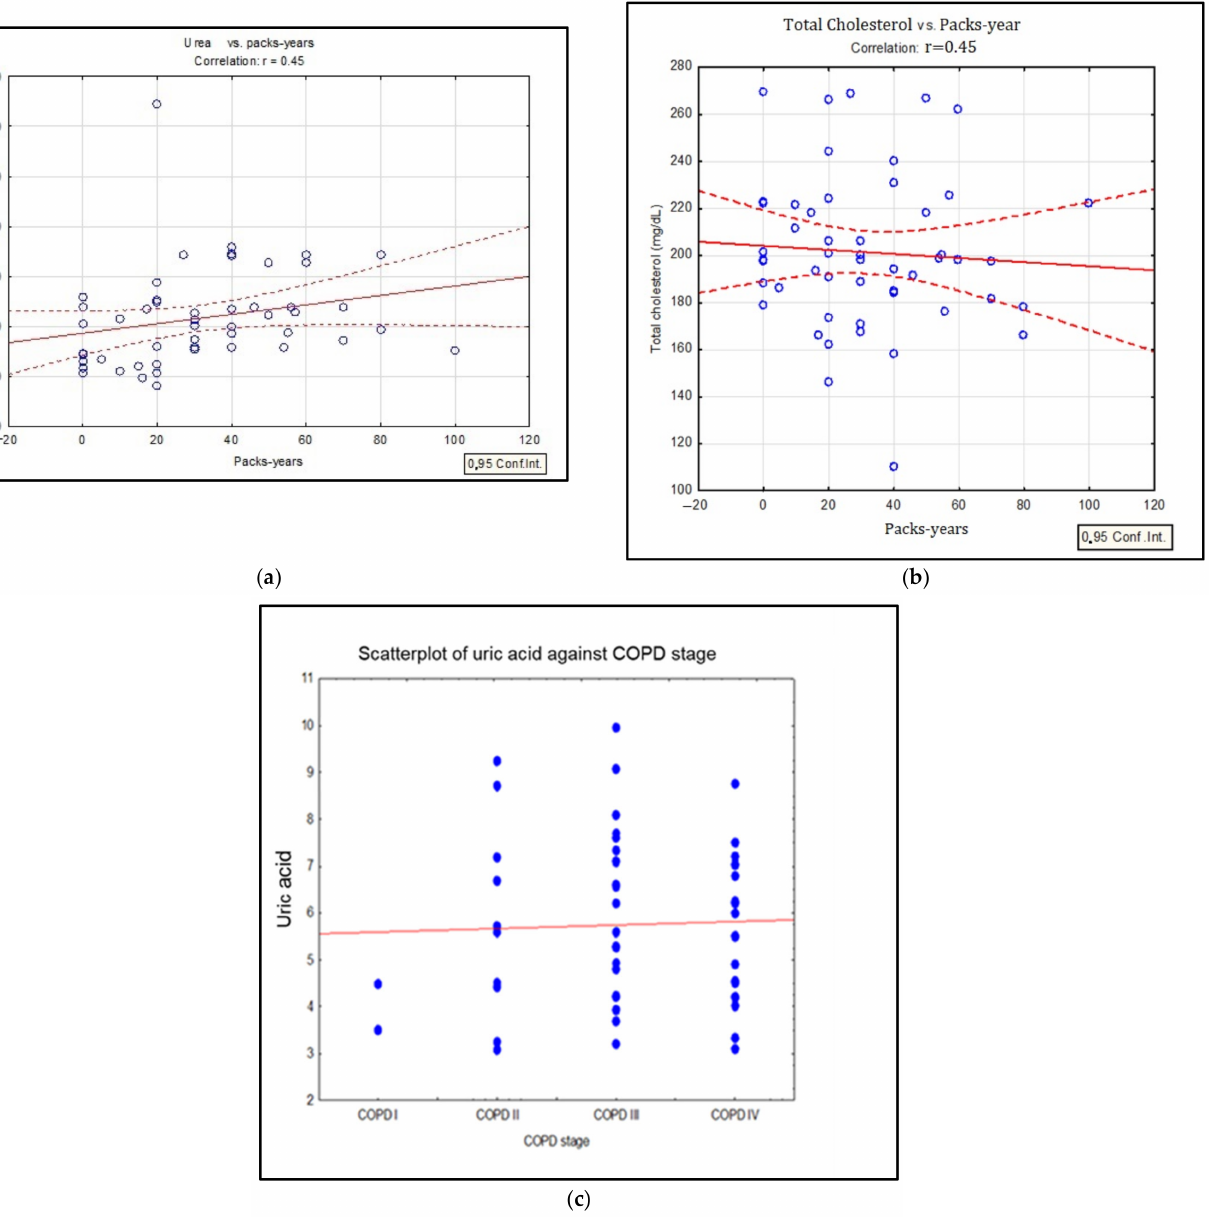
Figure 2. Linear regression between urea and PY (packs-years) ( a ); cholesterol and PY (packs- years) ( b ); uric acid and COPD stage ( c